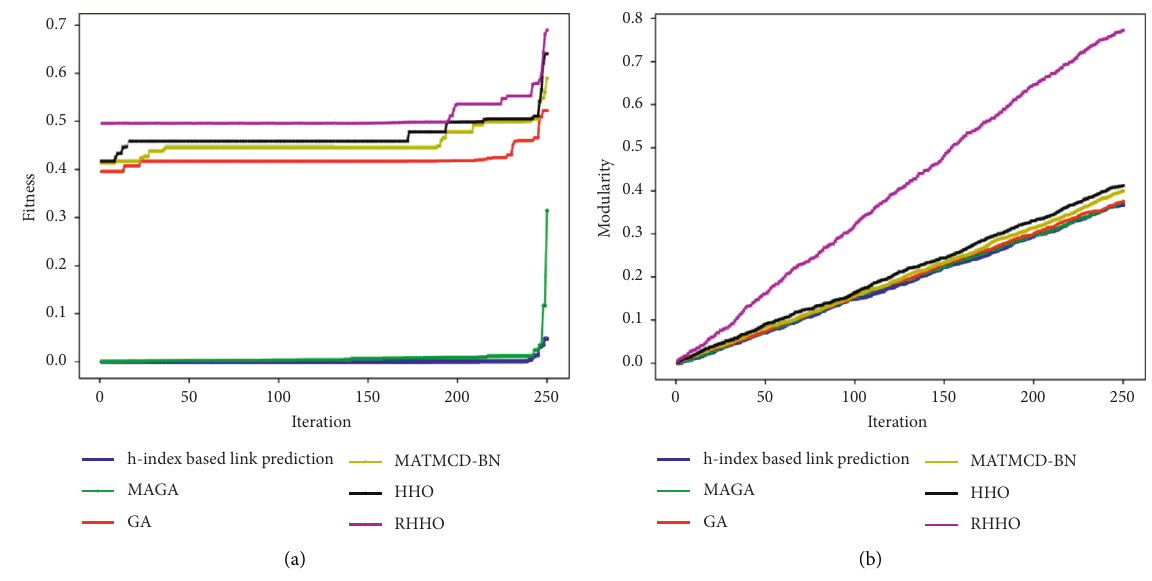
Figure 10: Analysis of methods using the Movie Lens 100K considering (a) fitness and (b)